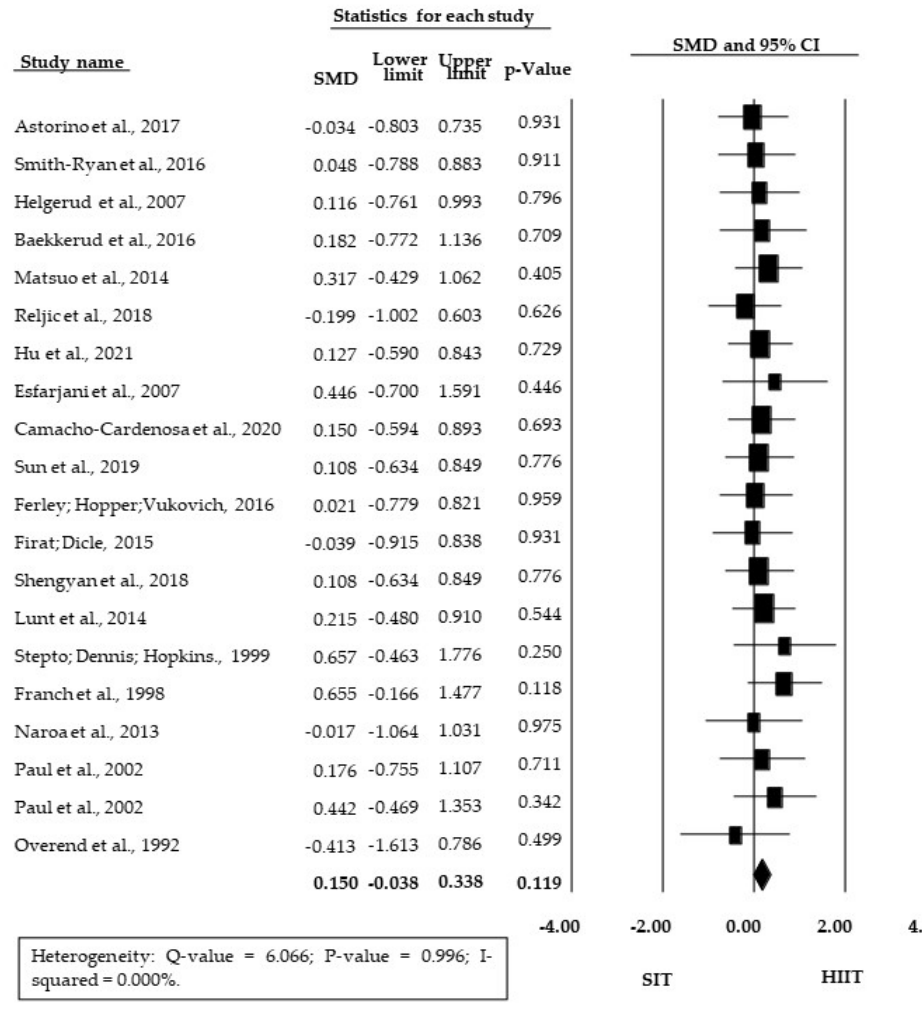
Figure 2. Forest plot of standardized mean difference (SMD) between HIIT and SIT; 95% CI, 95% confidence interval; SIT, sprint interval training; HIIT, high-intensity interval training.